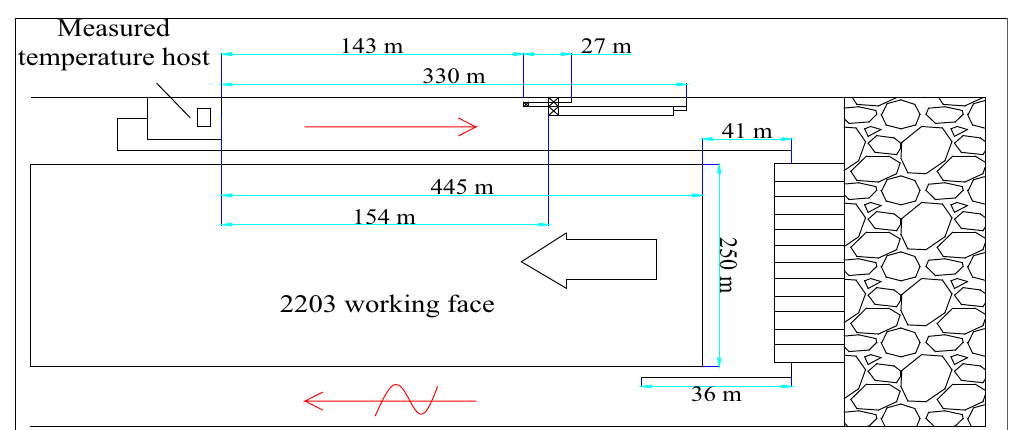
Fig. 3 Arrangement of the fiber optic temperature measurement system on the working face